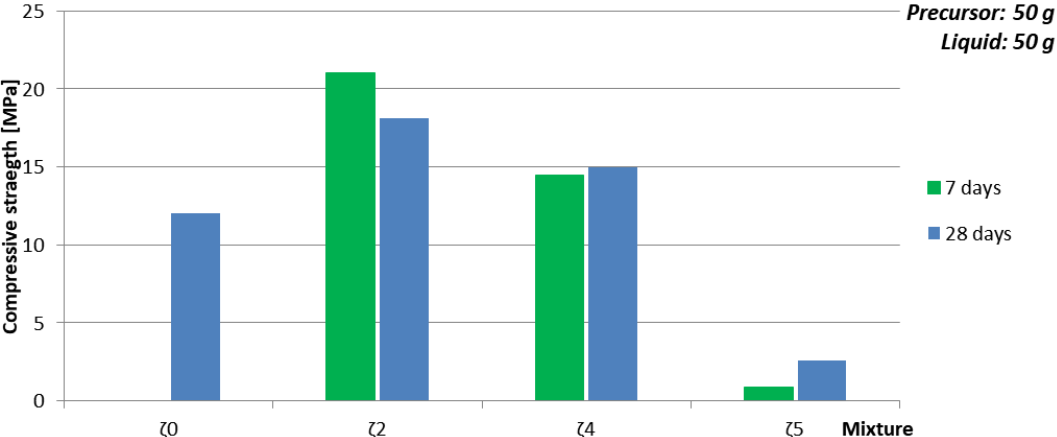
Figure 7. Compressive strength of AAM prepared with mixtures ζ 0 , ζ 2 , ζ 4 , and ζ 5 , cured on 70 °C for one day, measured one week after molding (green), and four weeks after molding (blue).